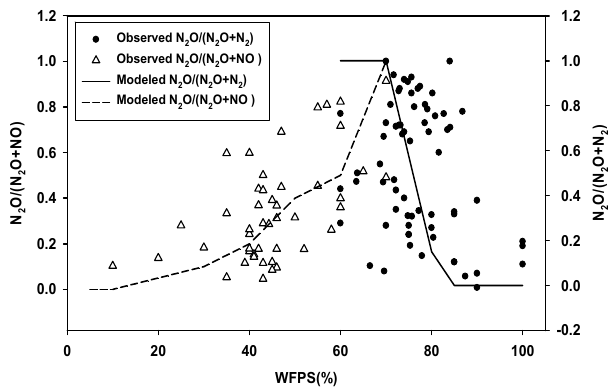
Fig. 4. Comparison of the ratios of N 2 O-N/(N 2 O-N + NO-N) and N 2 O-N/(N 2 O-N + N 2 -N) from field measurements (points) with ra- tios predicted by the gas partitioning model (lines). Additional in- formation on the field measurements is presented in